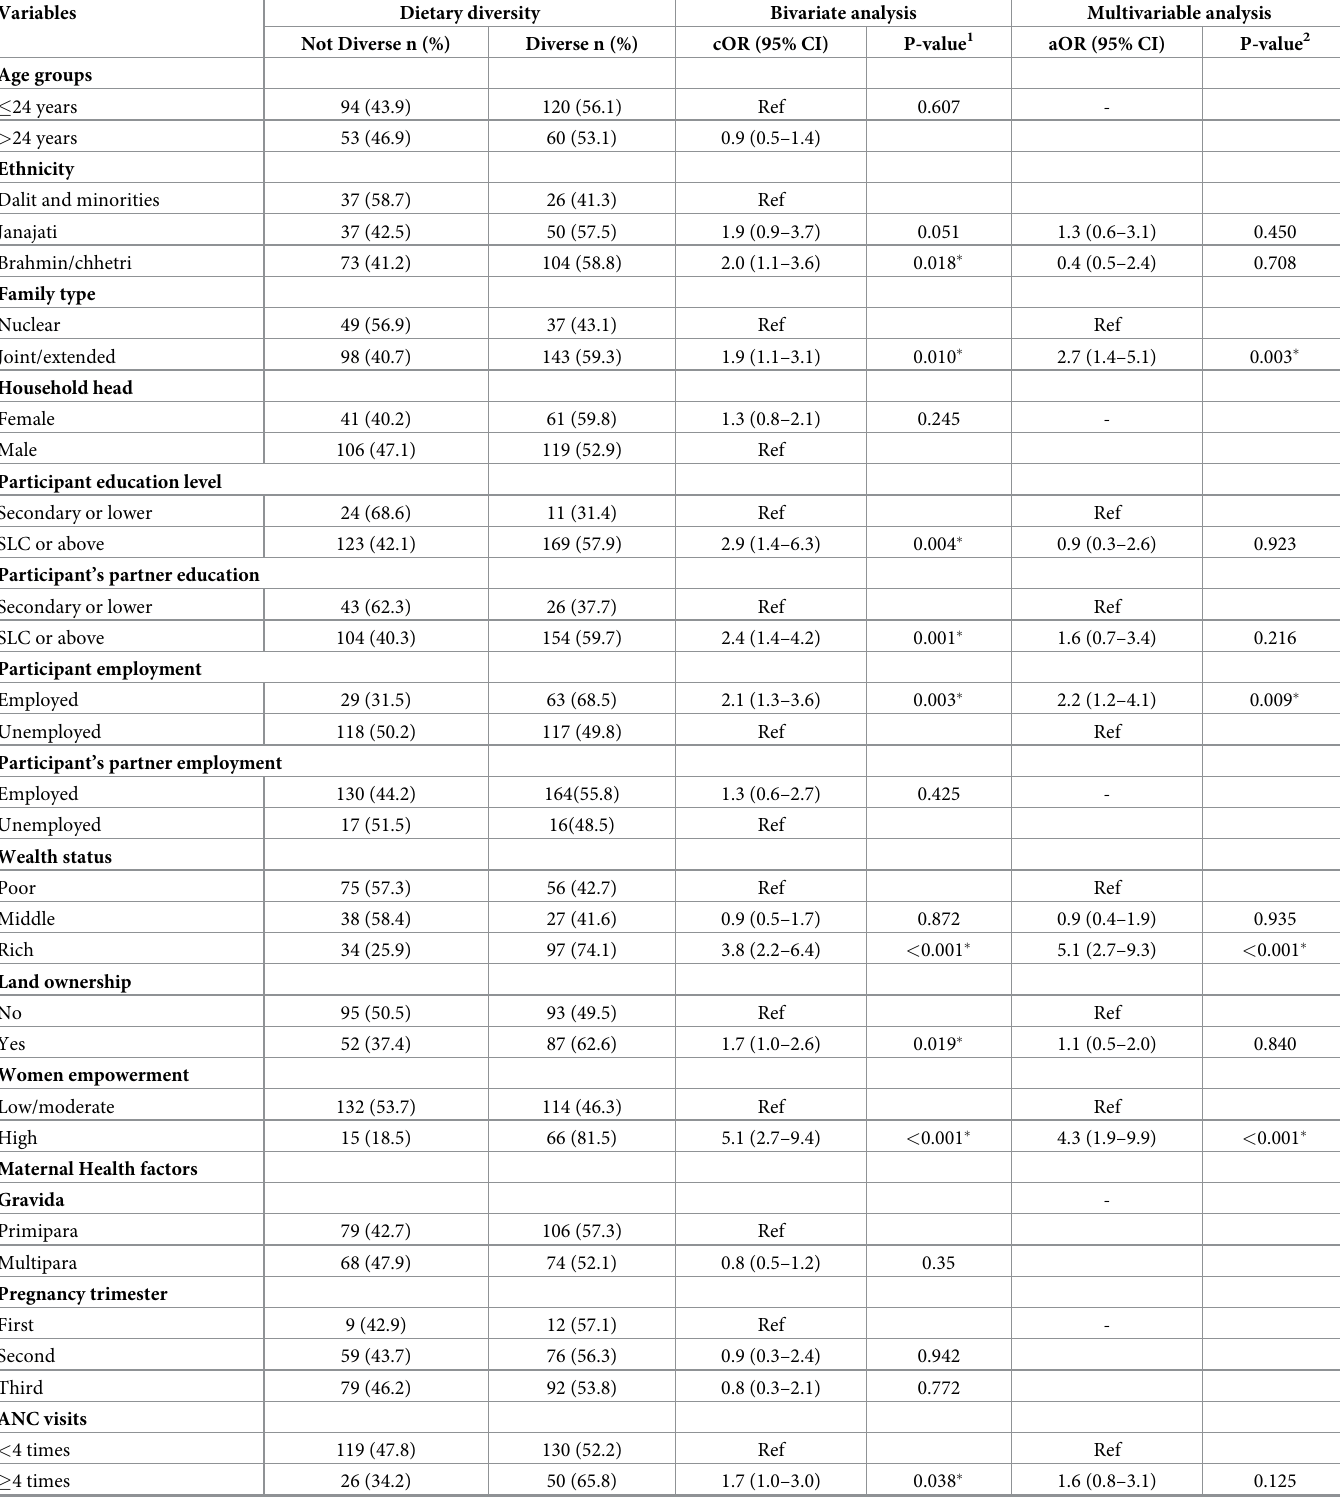
Table 3. Bivariate and multivariate binary logistic regression of factors associated with dietary diversity among pregnant women (n = 327).